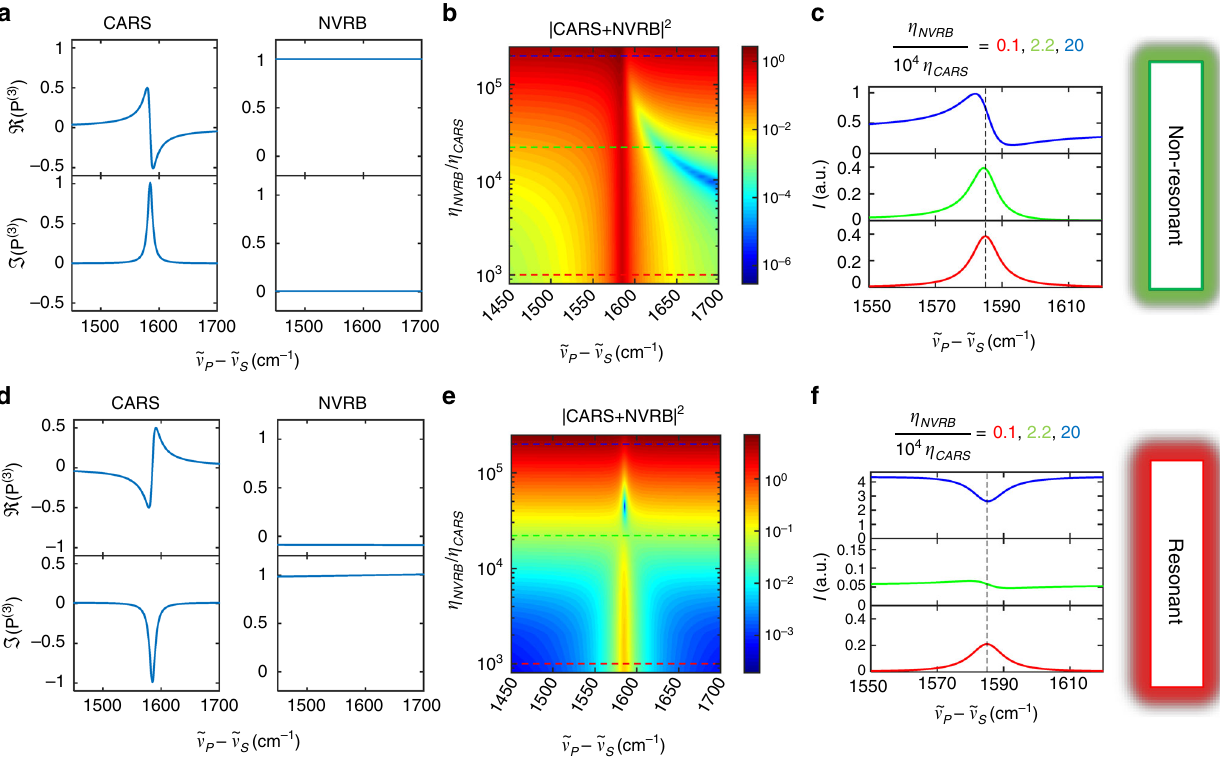
Fig. 4 CARS and NVRB response in electronically resonant and non-resonant condition. CARS and NVRB spectral pro fi les for a – c electronically nonresonant and d – f resonant regimes, as derived from Eqs. (5) and (6), considering 45,47 τ ba = τ da = τ ea = 10 fs, γ ca = FWHM( G )/2 = 6 cm − 1 . , =ð P ð 3 Þ , and <ð P ð 3 Þ , =ð P ð 3 Þ . Colormaps in b , e generalize a , d for different η NVRB / η CARS , as for Eqs. (7) and (8). In a , c Normalized <ð P ð 3 Þ NRVB Þ NRVB Þ CARS Þ CARS Þ c , f , selected spectra corresponding to three η NVRB / η CARS from the colormap are